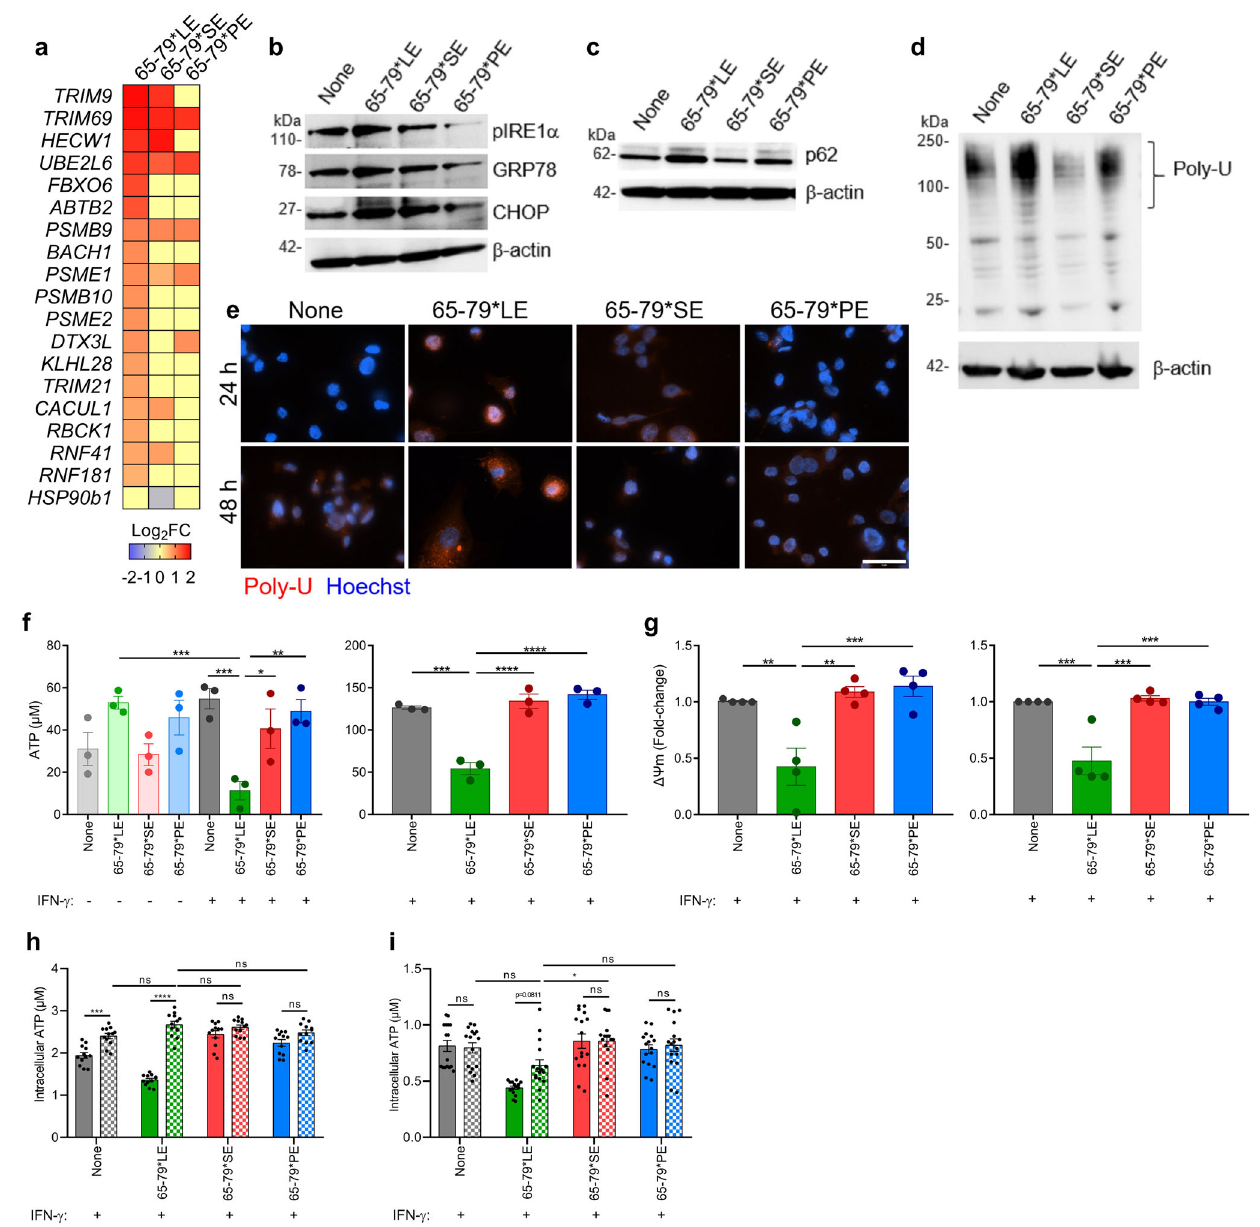
Fig. 3 Activation of ER stress, UPR and mitochondrial dysfunction by the LE in human and mouse macrophages. a Heatmap of endoplasmic reticulum- associated degradation pathway-related genes (Model B) modulated by 65-79*LE, versus 65-79*SE and 65-79*PE in IFN- γ -treated THP-1 macrophages. b – d Representative immunoblots of ER stress markers (pIRE1- α , GRP78, CHOP) b , proteasomal degradation marker (p62) c , and poly-ubiquitinated proteins d in THP-1 macrophages in the presence of 65-79*LE, 65-79*SE, or 65-79*PE. e Representative immunocytochemistry images of poly- ubiquitinated protein accumulation (red). Scale bar = 2 μ m. f Intracellular ATP levels reduction in allelic epitope-treated human THP-1 (left) and mouse RAW 264.7 (right) macrophages ( n = 3). g Mitochondrial membrane potential in allelic epitope-treated THP-1 (left) and RAW 264.7 (right) macrophages, as determined by tetramethylrhodamine ethyl ester (TMRE), red ( n = 4). h Baricitinib (10 μ g/mL) shows allele-nonspeci fi c inhibitory effect on LE-activated reduction of intracellular ATP in RAW 264.7 macrophages, ( n = 3). i Neutralization of human IFN-alpha receptor with IFNAR2 Monoclonal Antibody (10 μ g/mL) shows a trend for recovery of LE-activated intracellular ATP levels, in THP-1-derived macrophages, ( n = 3). In h , i solid-color and dotted-color bars represent, respectively, absence or presence of inhibitors. Uncropped immunoblots are shown in Supplementary Fig. S9. Data represent mean ± SEM; One-way ( f , g ), or two-way ( h , i ) ANOVA.*p < 0.05; ** p < 0.01; *** p < 0.001, **** p < 0.0001. See also Supplementary Fig.